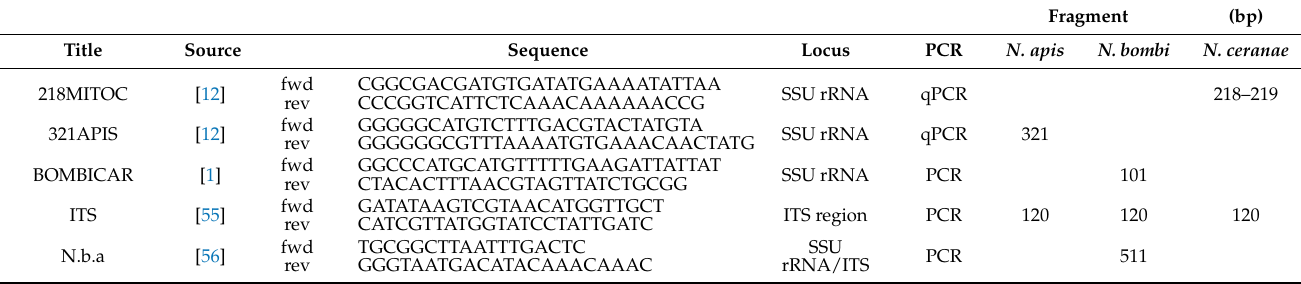
Table 2. Primers used to diagnose Nosema spp.